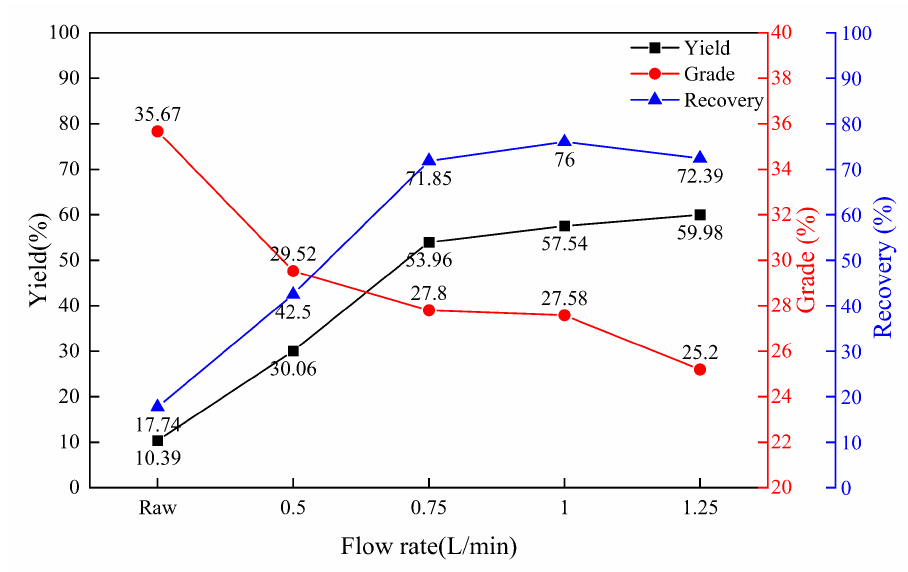
Figure 5. Magnetic separation effect between different gas inlet flow rates at 75 mT.